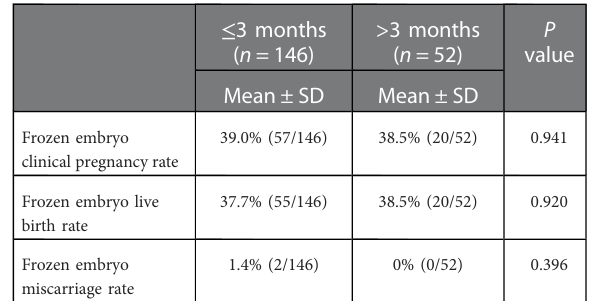
TABLE 5 Thawing and transplantation at different time after laparoscopic